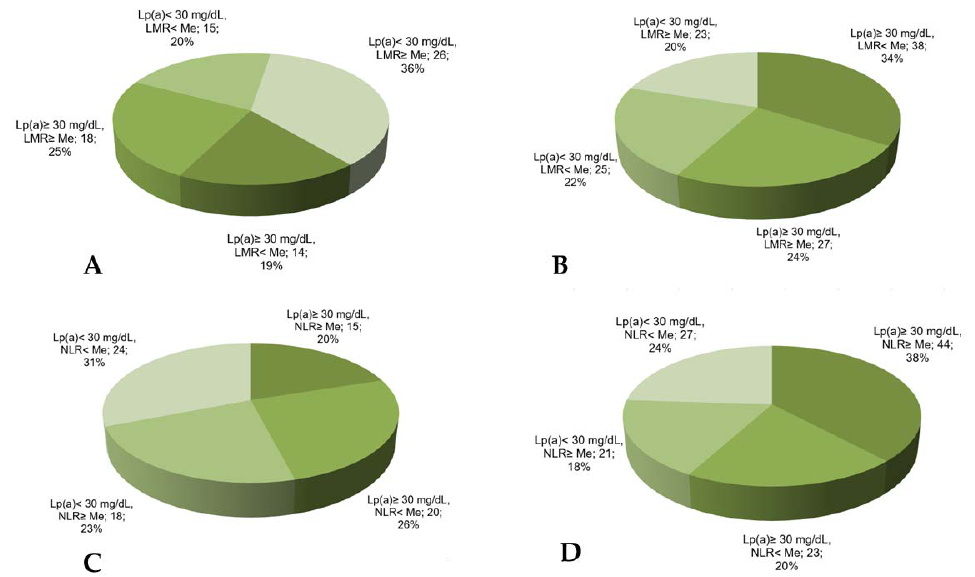
Figure 4. The proportion of CHD patients according to Lp(a) concentration, lymphocyte-to-monocyte ratio, or neutrophil-to-lymphocyte ratio in groups without ( A , B ) or with ( C , D ) MACE. LMR— lymphocyte-to-monocyte ratio, NLR—neutrophil-to-lymphocyte ratio, Me—median. Median for LMR = 4.18, for NLR = 2.66.